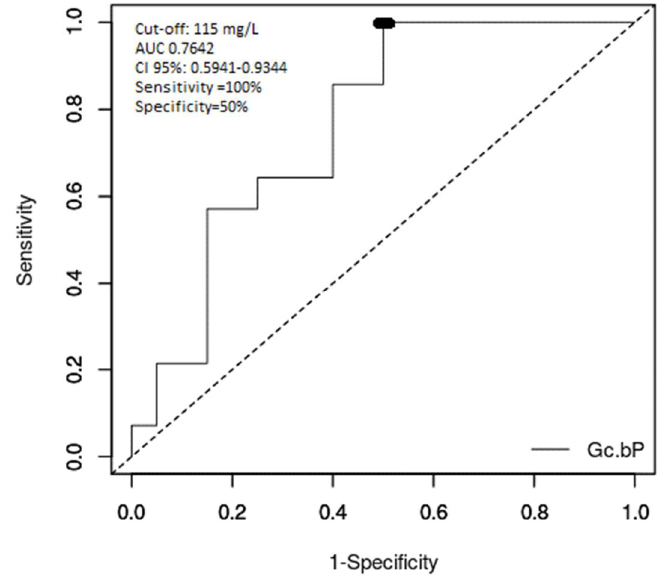
Figure 2. ROC curve for analysis of the outcome of acute liver failure in children using Gc-globulin serum levels.